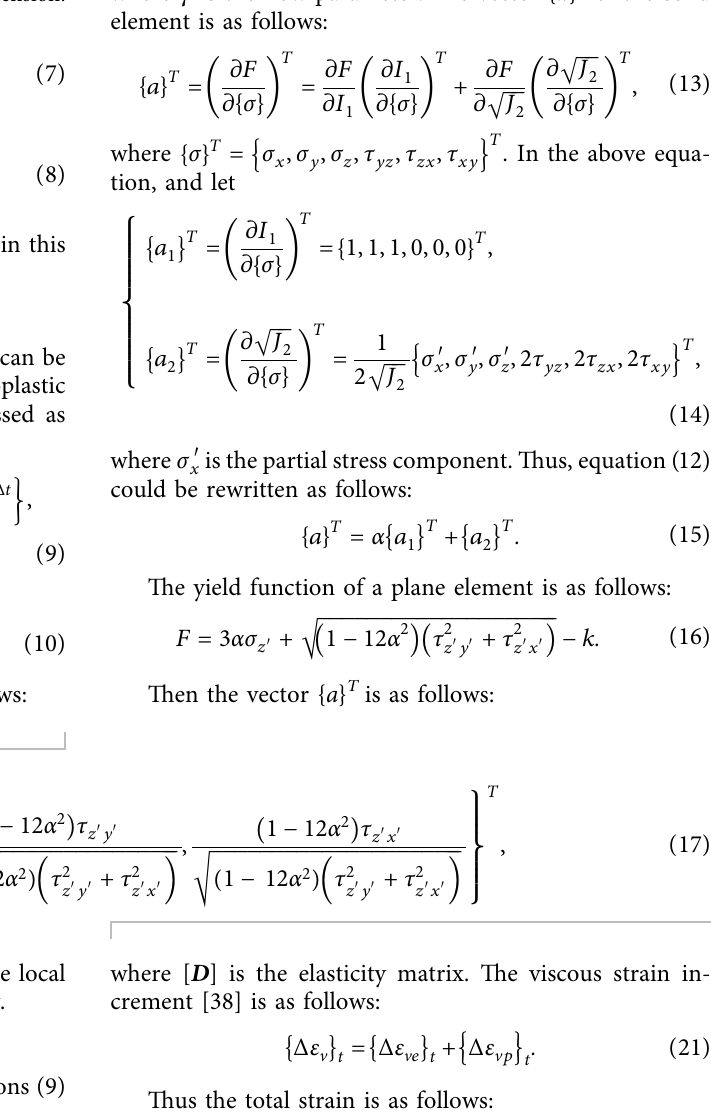
Figure 1: A model of viscous elastic-plasticity in one